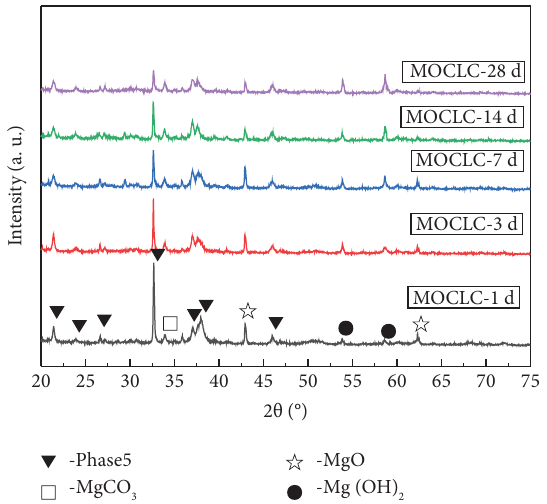
Figure 8: XRD patterns of MOCLC at diferent immersion